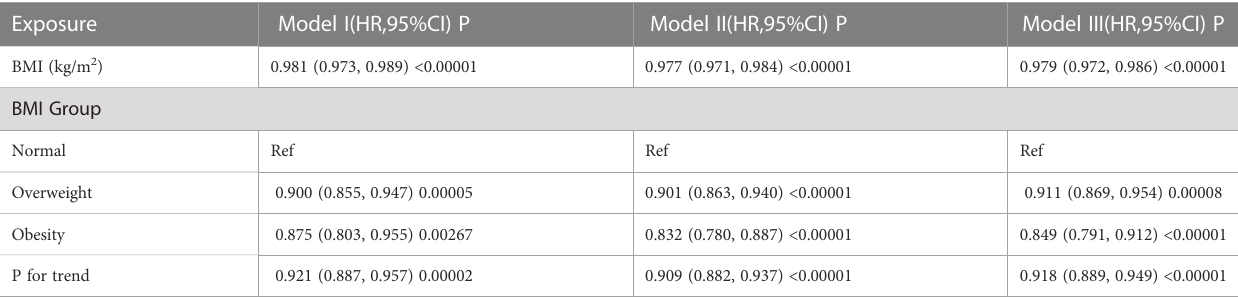
TABLE 6 Relationship between BMI and the probability of reverting from IFG to normoglycemia in different sensitivity analyses.